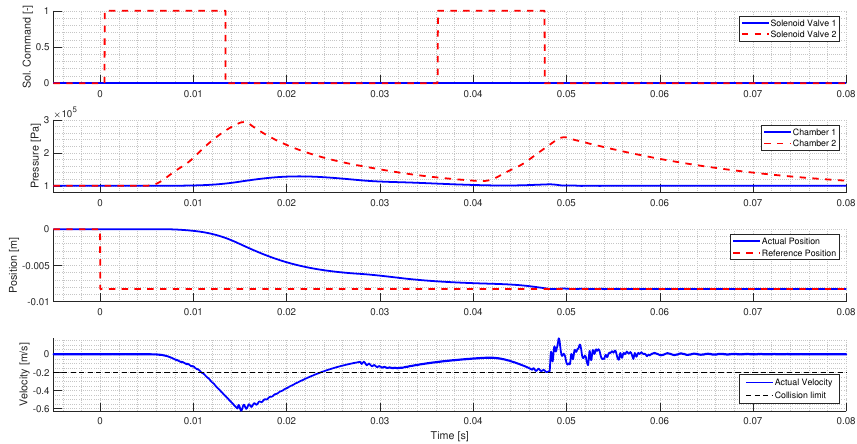
Figure 6. Neutral to Low gear change (simulation).